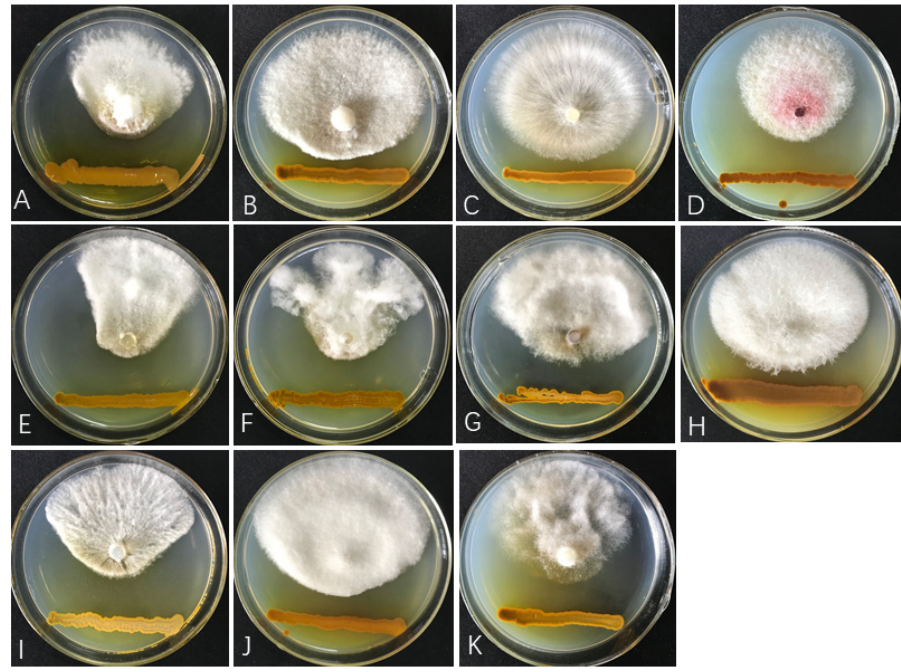
Figure 1. In vitro antifungal activity of ST-TJ4 against 11 phytopathogenic fungi in dual-culture assays. ( A ) Pestalotiopsis versicolor ; ( B ) Cytospora chrysosperma ; ( C ) Rhizoctonia solani ; ( D ) Fusarium